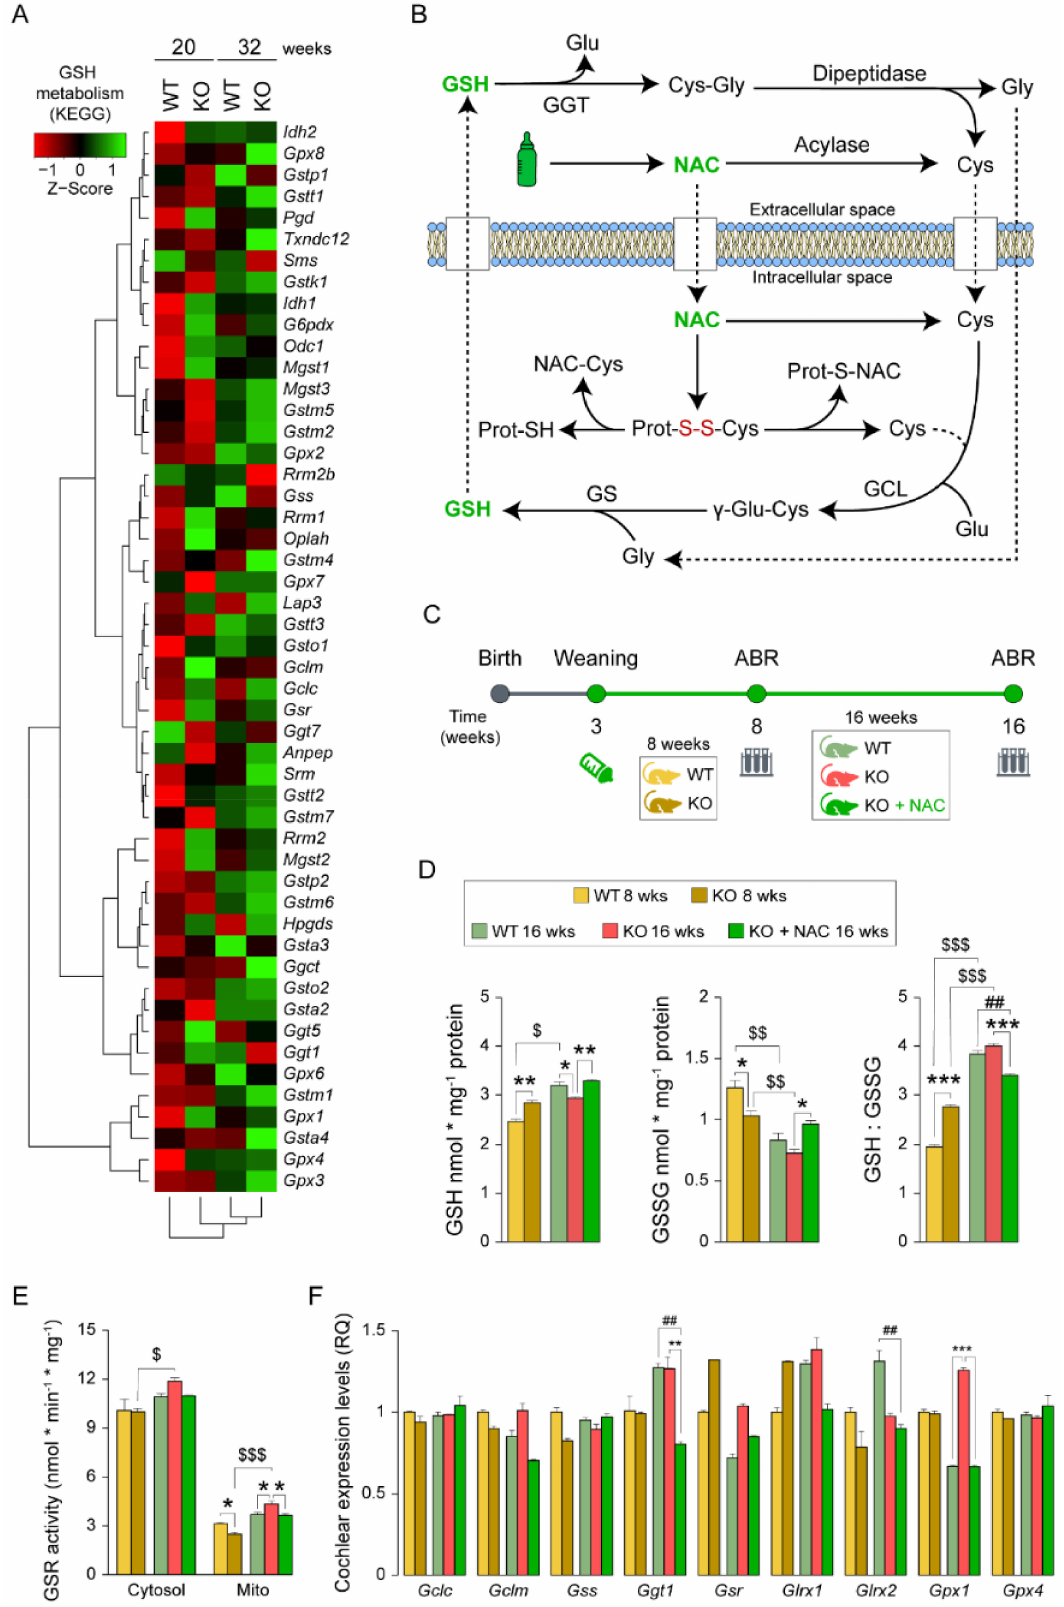
Figure 2. Impact of N-acetylcysteine administration for glutathione metabolism. ( A ) Glutathione (GSH) metabolism (KEGG database) heatmap generated from differential expression data derived from RNAseq. ( B ) Scheme illustrating GSH biosynthe- sis, extracellular recycling and N-acetylcysteine (NAC) antioxidant power. GSH and NAC appear in green;